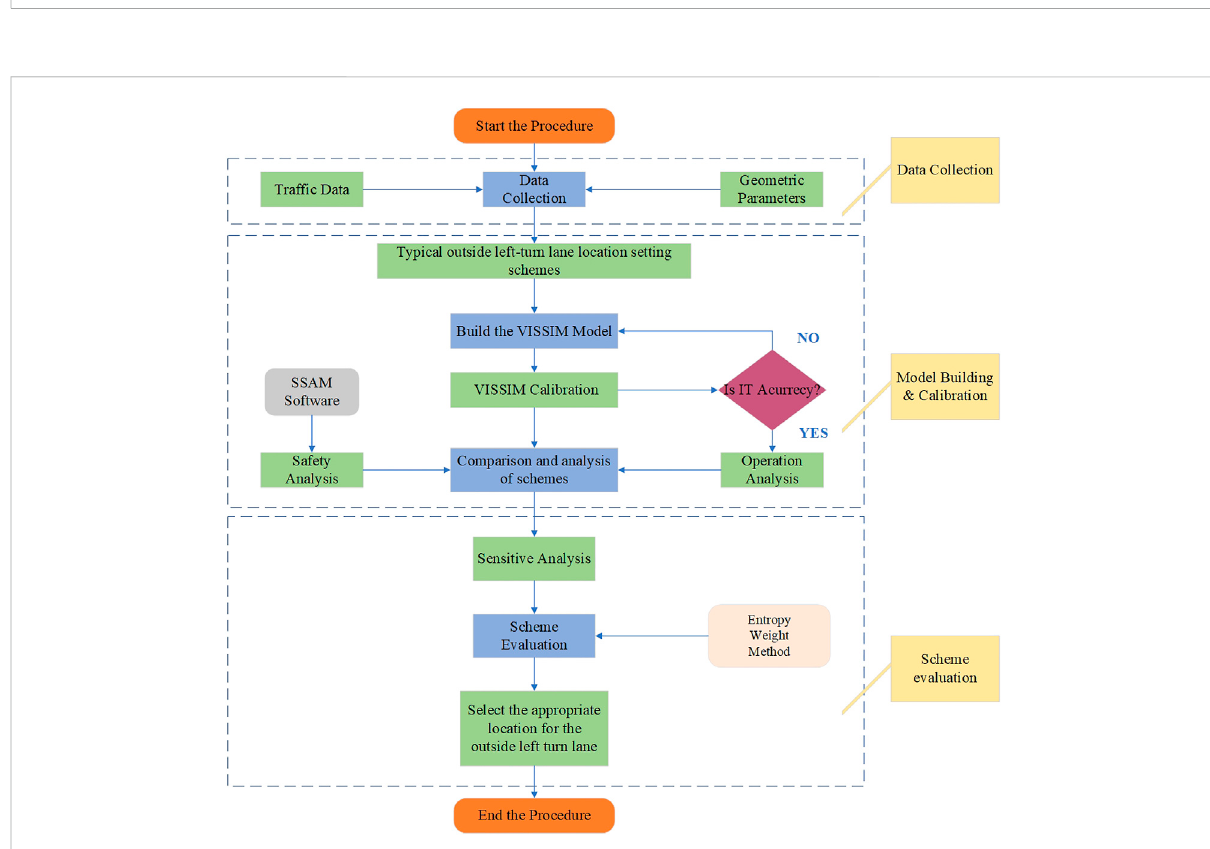
FIGURE 2 The fl owchart of the evaluation and analysis model based on EWM for design